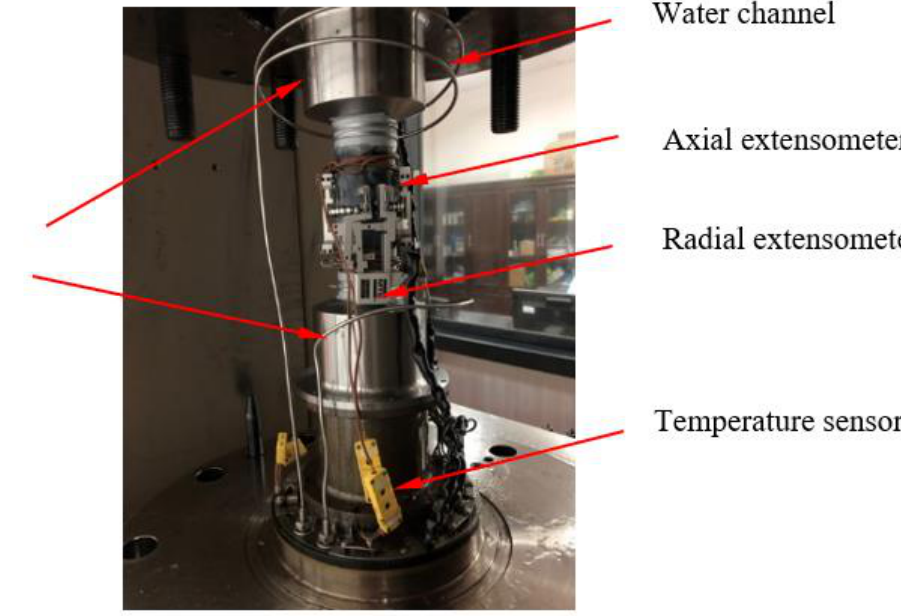
Figure 3. Installation diagram of seepage test specimen.